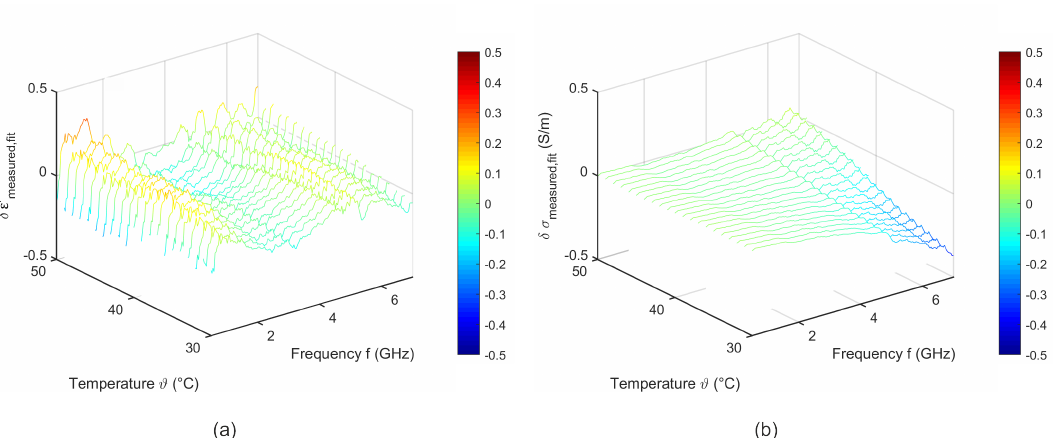
Figure 12. Difference between the measured and the temperature dependent two pole Cole-Cole model of ( a ) relative permittivity and ( b ) effective conductivity of porcine muscle.